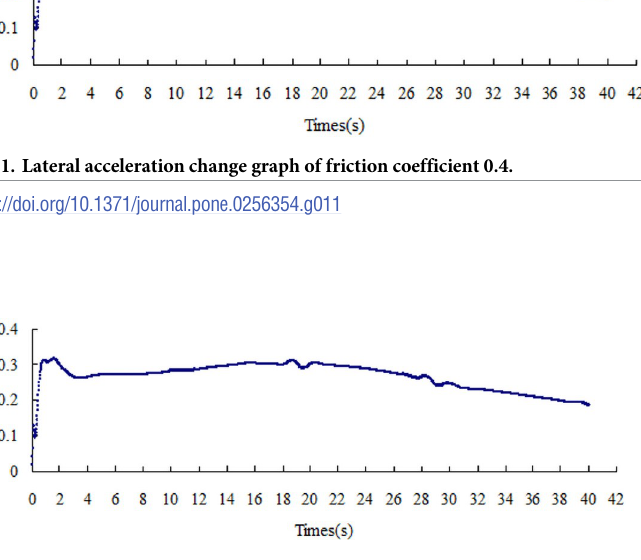
Fig 12. Lateral acceleration change graph of friction coefficient 0.5.